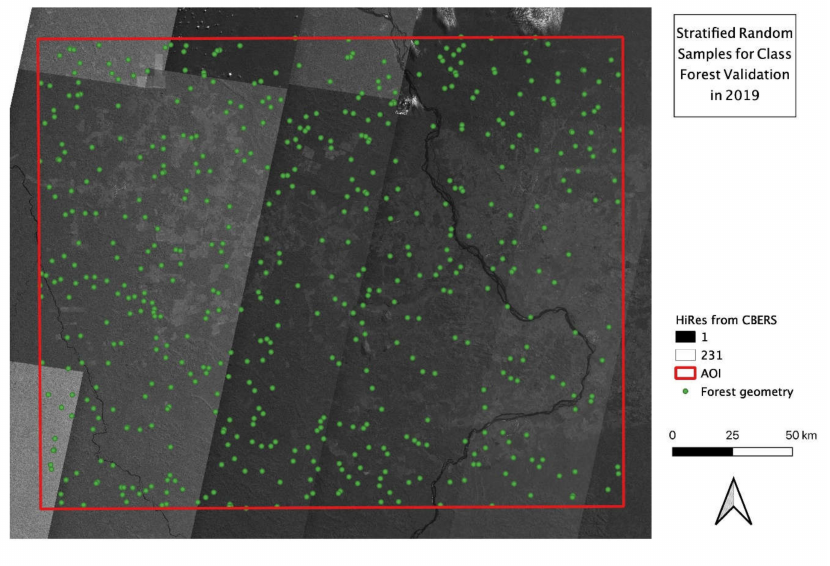
Figure 2. Stratified random distributed validation samples generated for class Forest in 2019. AOI: area of